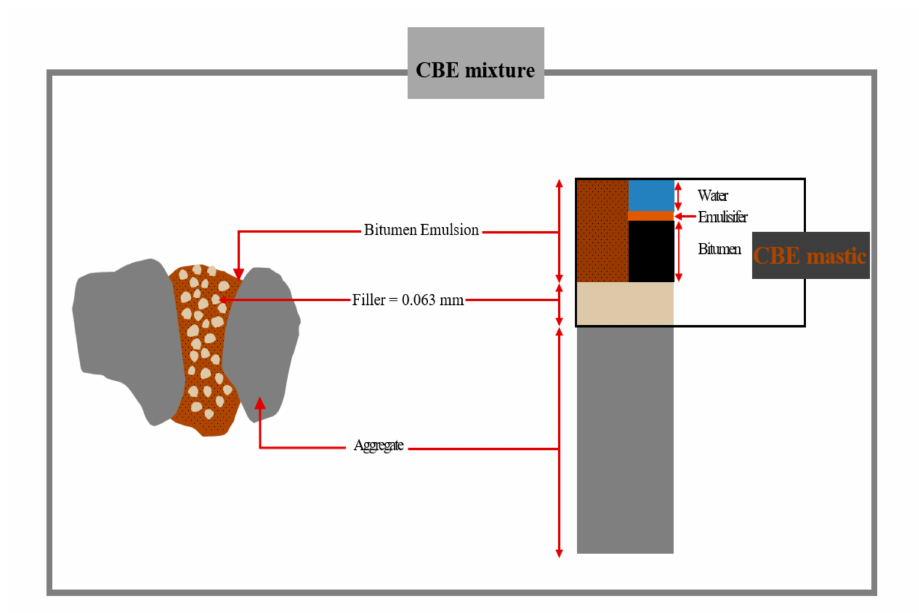
Figure 1. A schematic showing the Cold Bitumen Emulsion (CBE) mixture